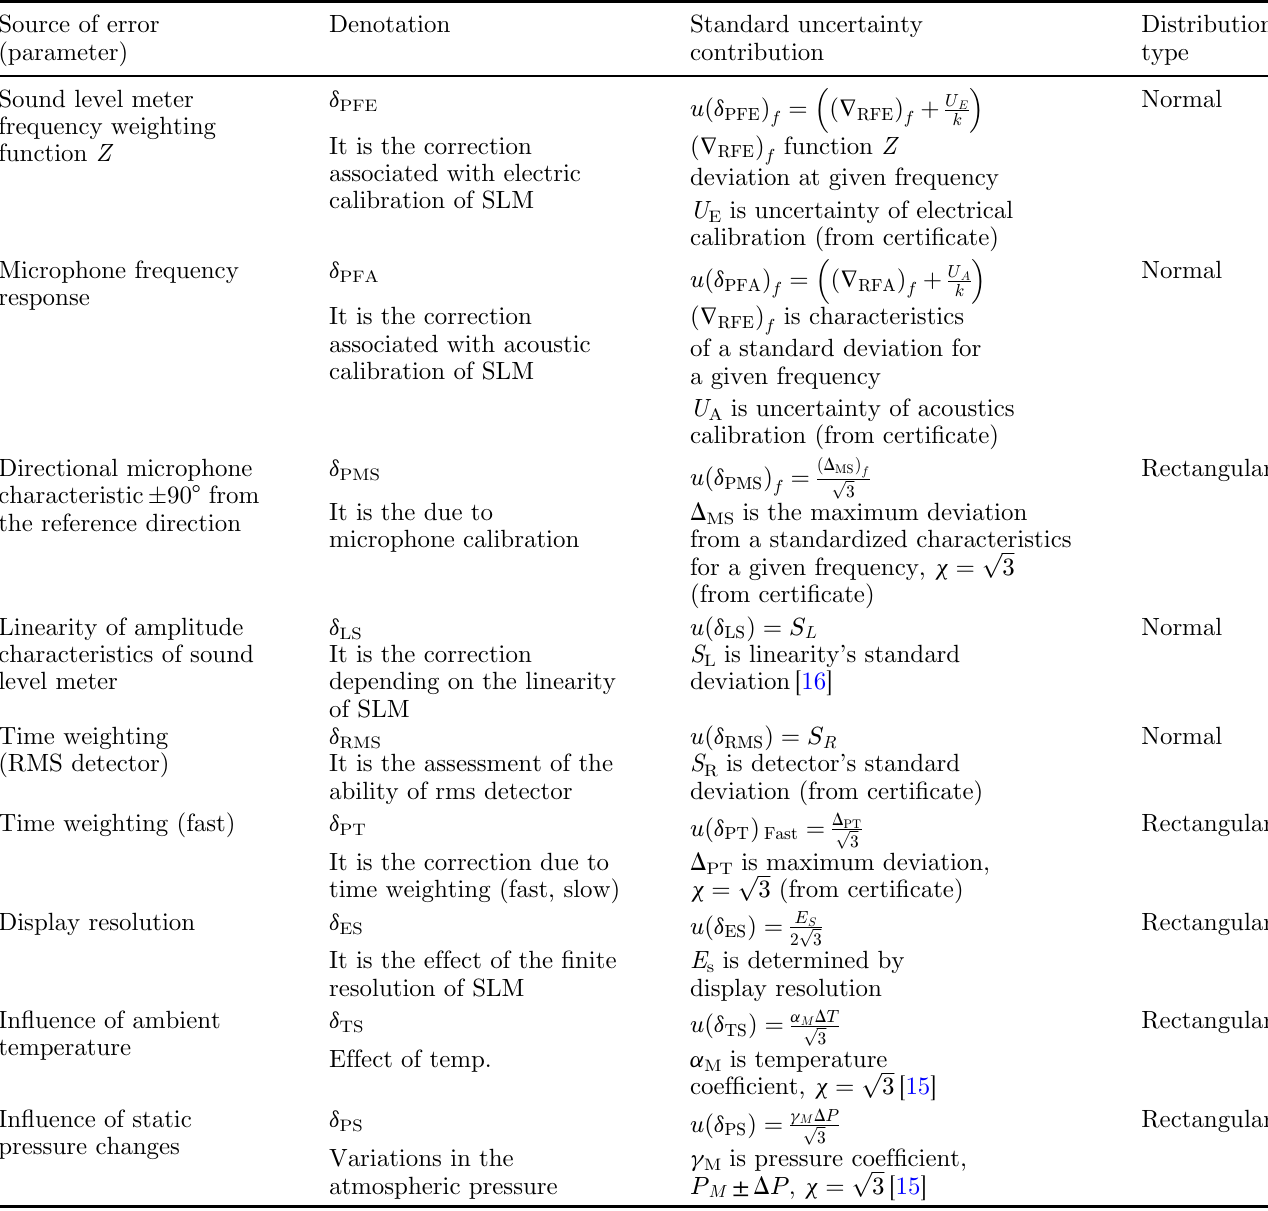
Table 1. Error sources and the determination of standard uncertainties contributions